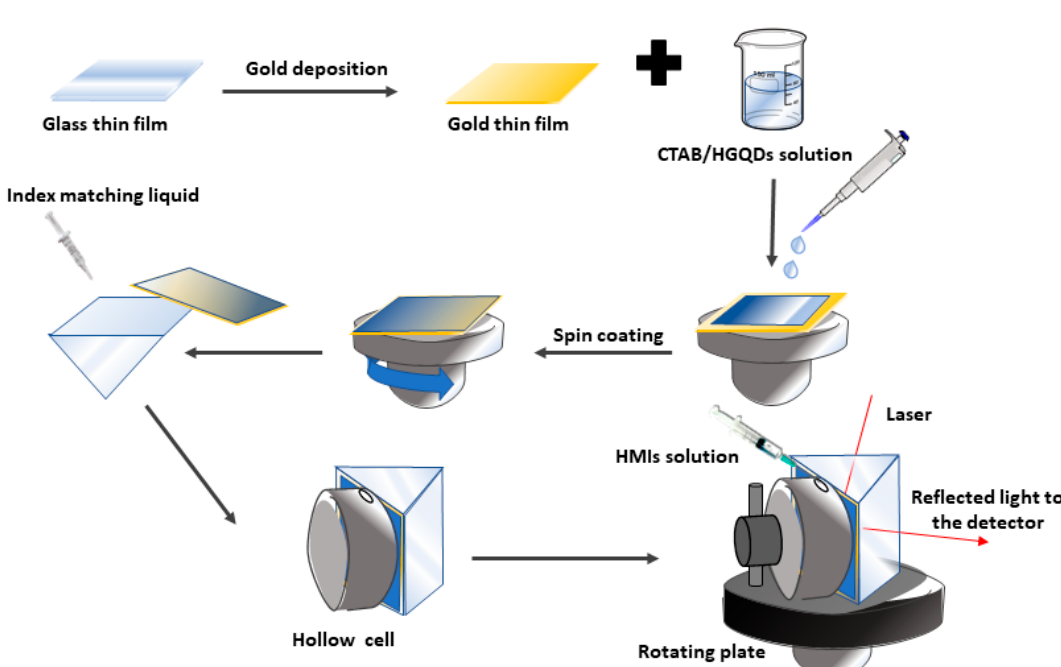
Figure 2. Illustration of the preparation process of the CTAB/HGQDs thin film for surface plasmon resonance (SPR) spectroscopy.